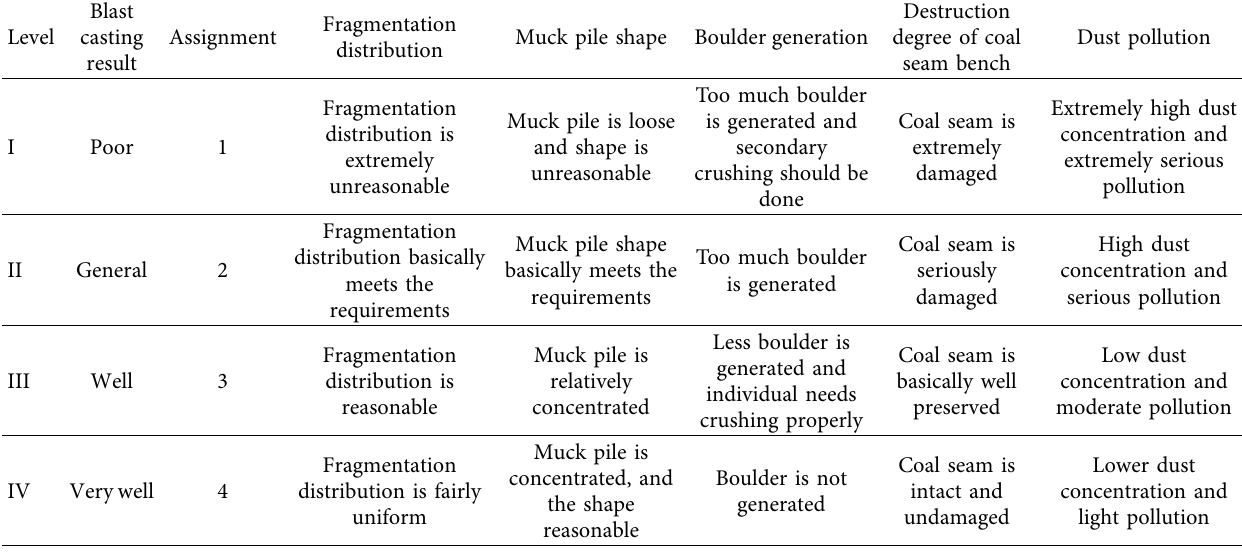
Table 2: The grading and quantitative standards of qualitative indicators for evaluating blast casting results. Level